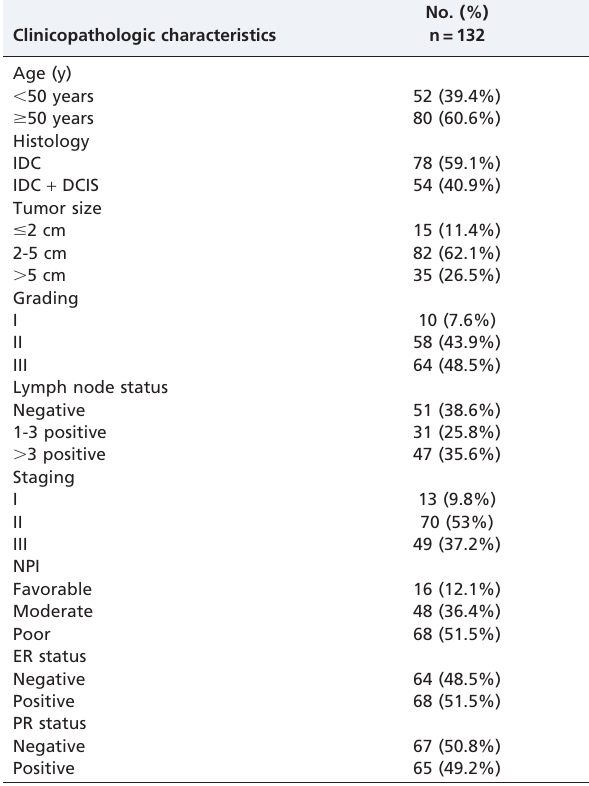
Table 1 - Clinicopathological data of 132 invasive ductal breast carcinoma